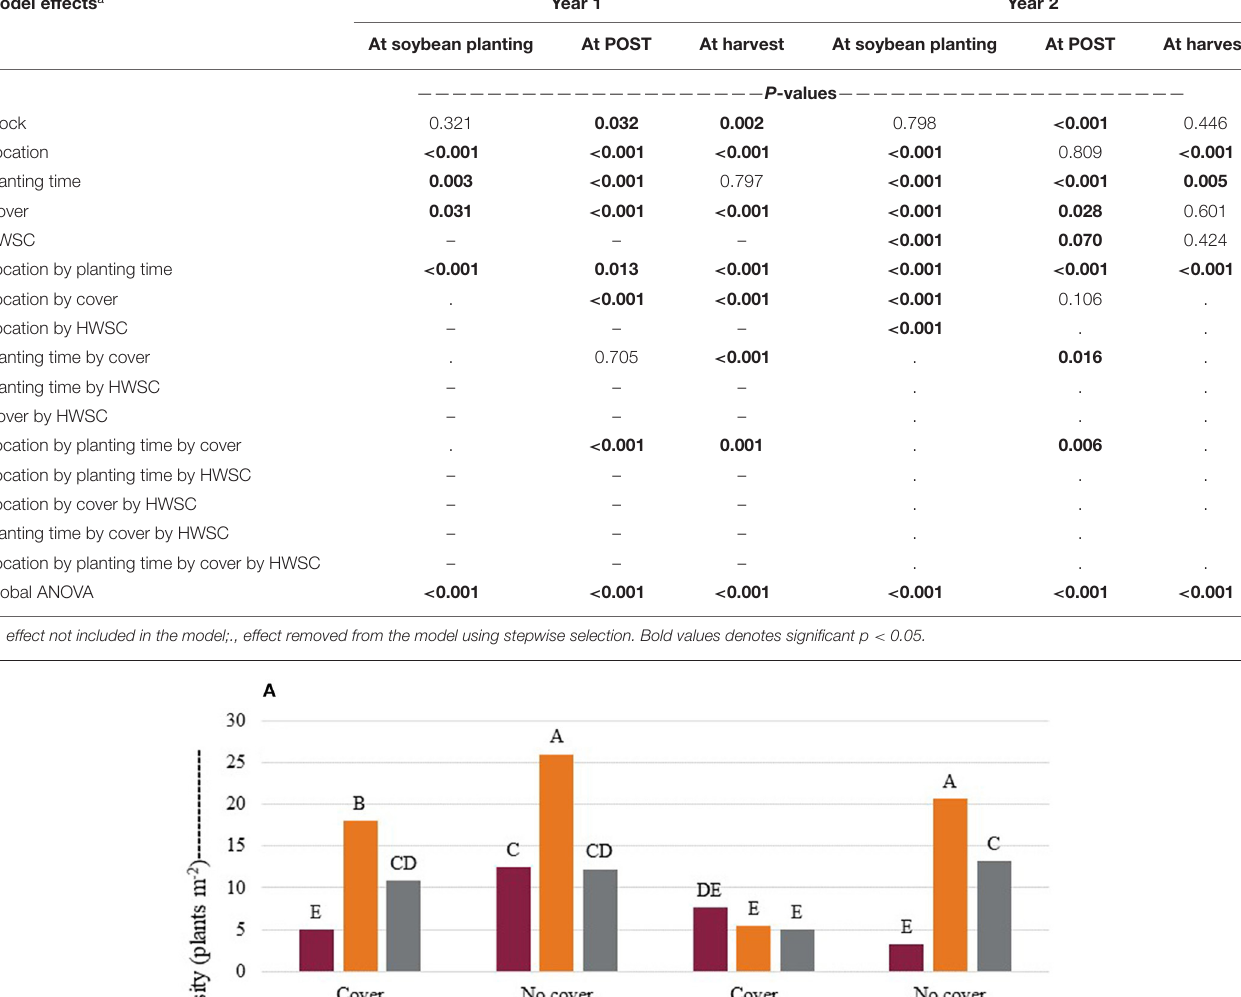
TABLE 2 | Effects table for common ragweed density across all locations for years 1 and 2 of field experiments at Blacksburg and Lawrenceville, VA, USA in 2017–2018 and Blackstone, VA, USA in 2018–2019. Model effects a